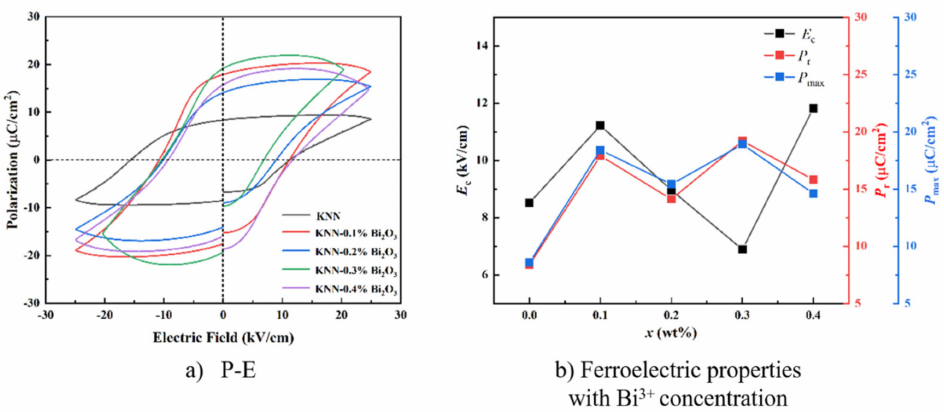
Figure 6. Ferroelectric properties of KNN-xBi 2 O 3 piezoelectric